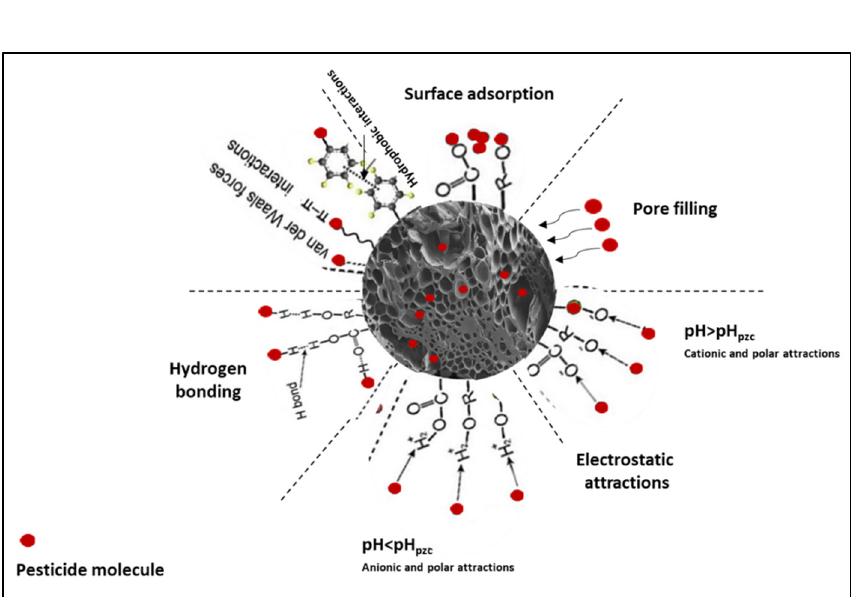
Figure 4. Presumed mechanism for pesticide molecules adsorption on biochar.